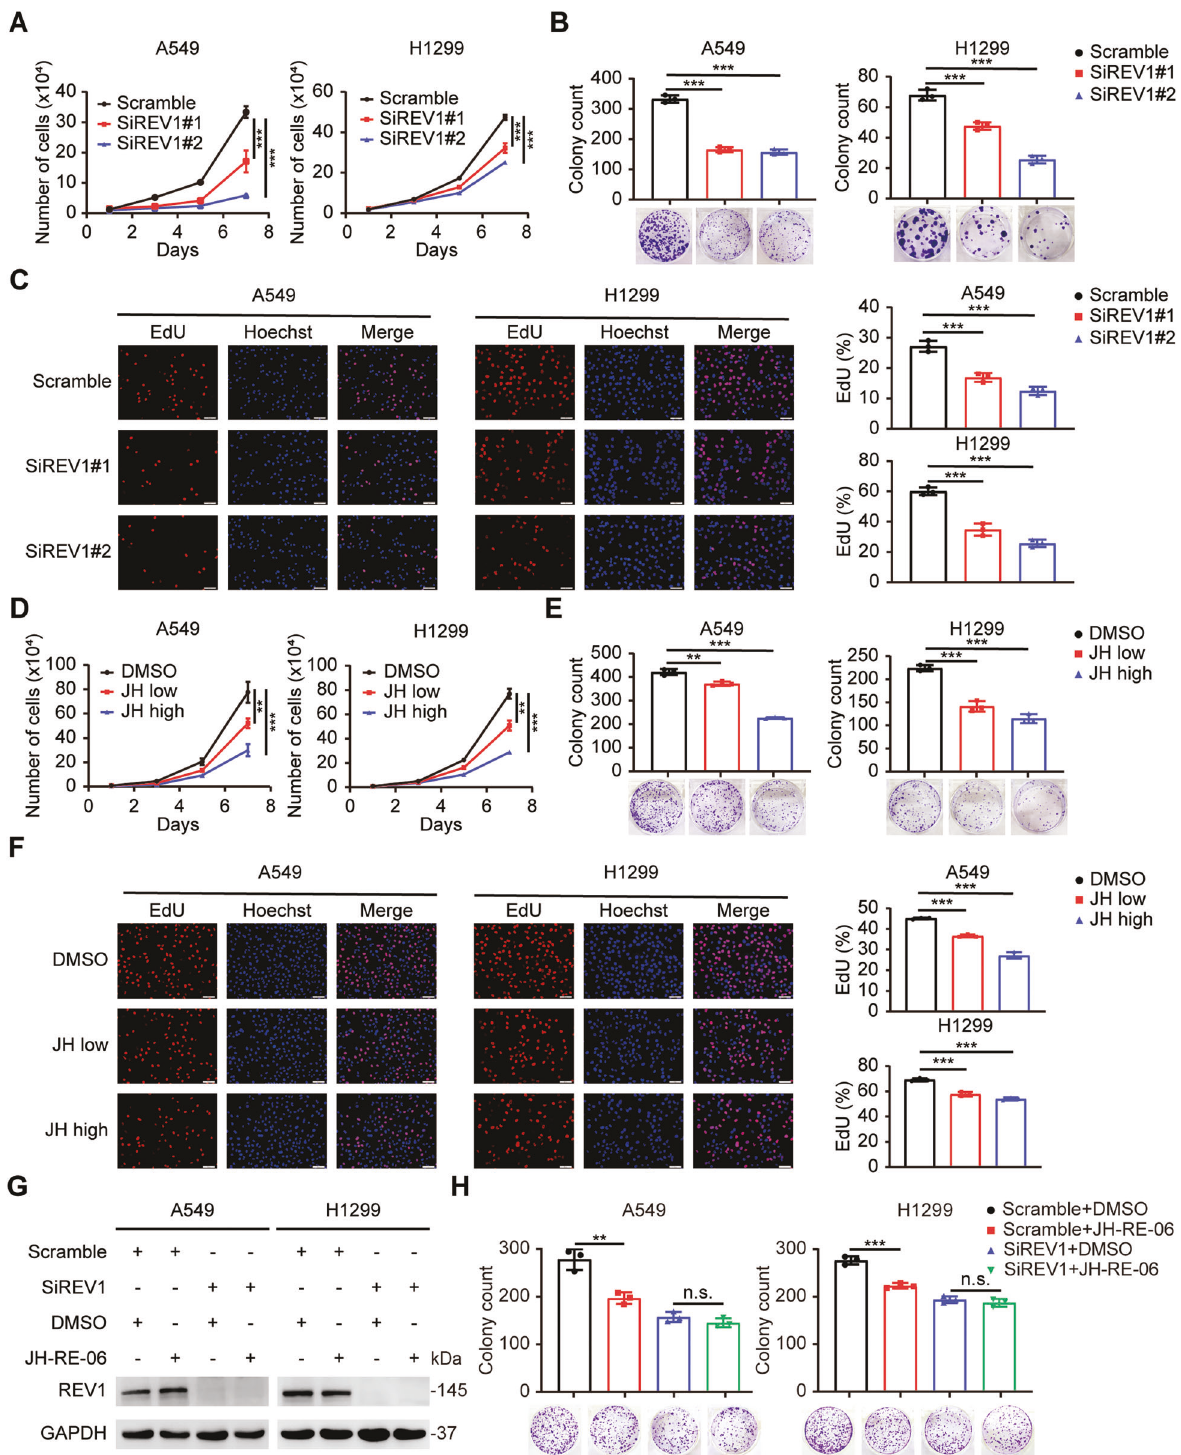
Fig. 2 REV1 promotes the growth and proliferation of lung cancer cells. A REV1 silencing slowed the growth of A549 and H1299 cells. *** P < 0.001 ( n = 3). B Knockdown of REV1 signi fi cantly decreased the colony formation ability of lung cancer cells. *** P < 0.001 ( n = 3). C The proliferation ability of A549 and H1299 cells was evaluated by an EdU incorporation assay. *** P < 0.001 ( n = 3). Scale bar: 50 μ m. D – F JH-RE-06 inhibited the growth and proliferation ability of A549 and H1299 cells in a concentration-dependent manner, as indicated by cell growth curves, plate colony formation assays and EdU incorporation assays. ** P < 0.01, *** P < 0.001 ( n = 3). Scale bar: 50 μ m. G , H JH-RE-06 inhibits the proliferation ability of lung cancer cells in a REV1-dependent manner. ** P < 0.01, *** P < 0.001 ( n = 3). n.s. indicates no statistically signi fi cant difference ( P > 0.05, n =